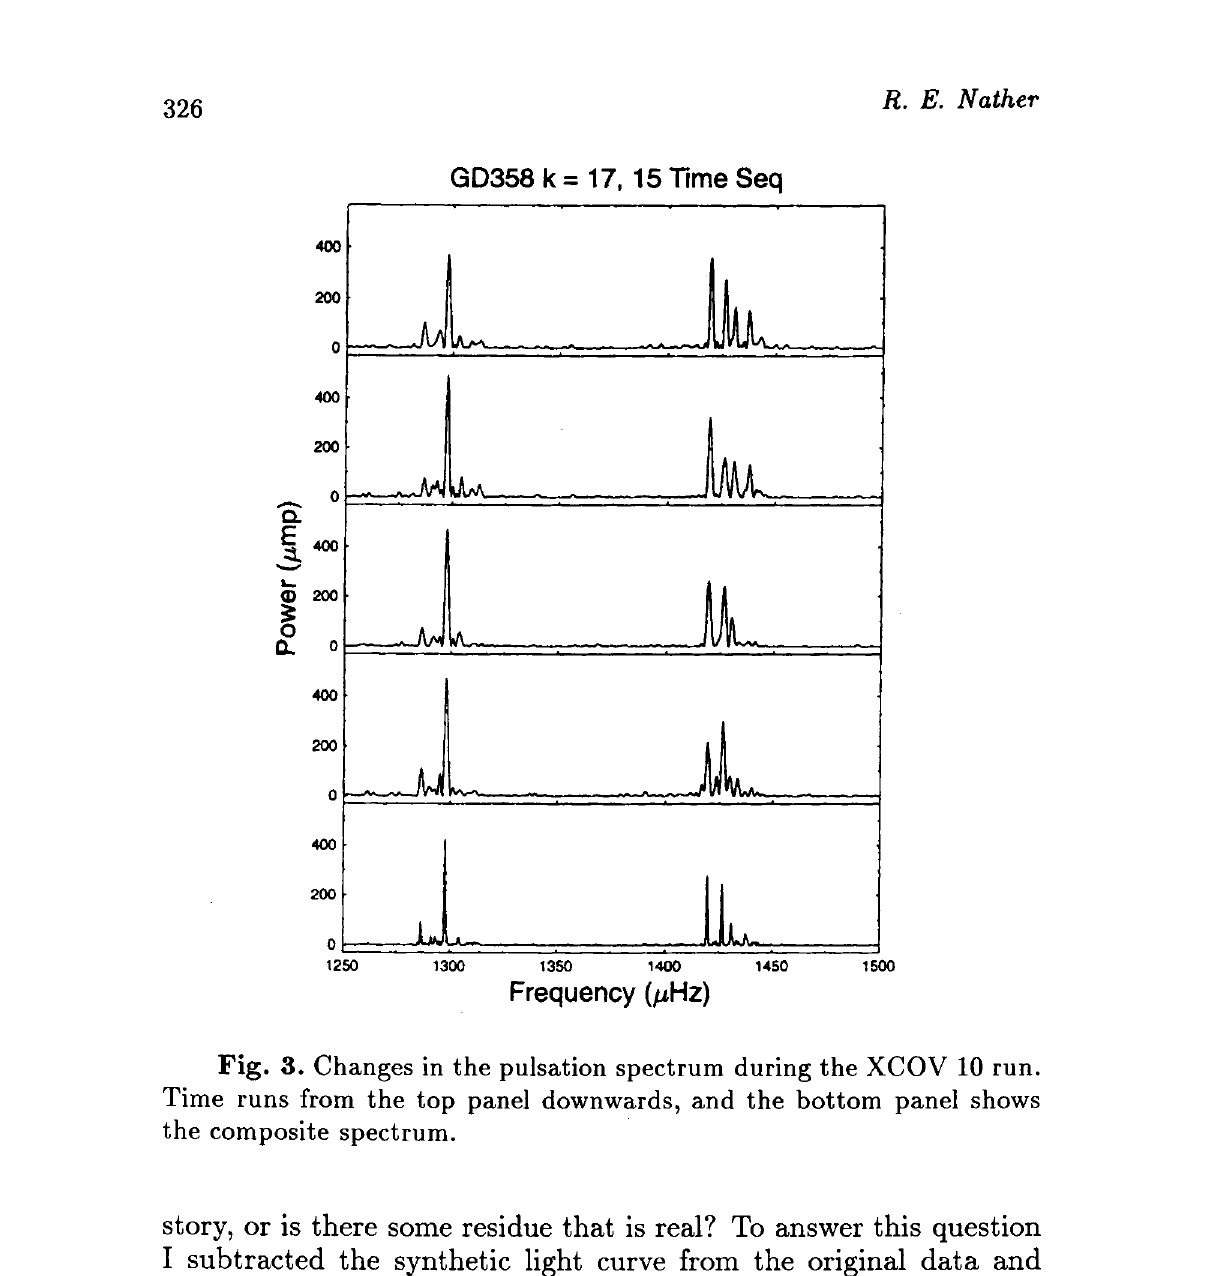
Fig. 3. Changes in the pulsation spectrum during the XCOV 10 run. Time runs from the top panel downwards, and the bottom panel shows the composite